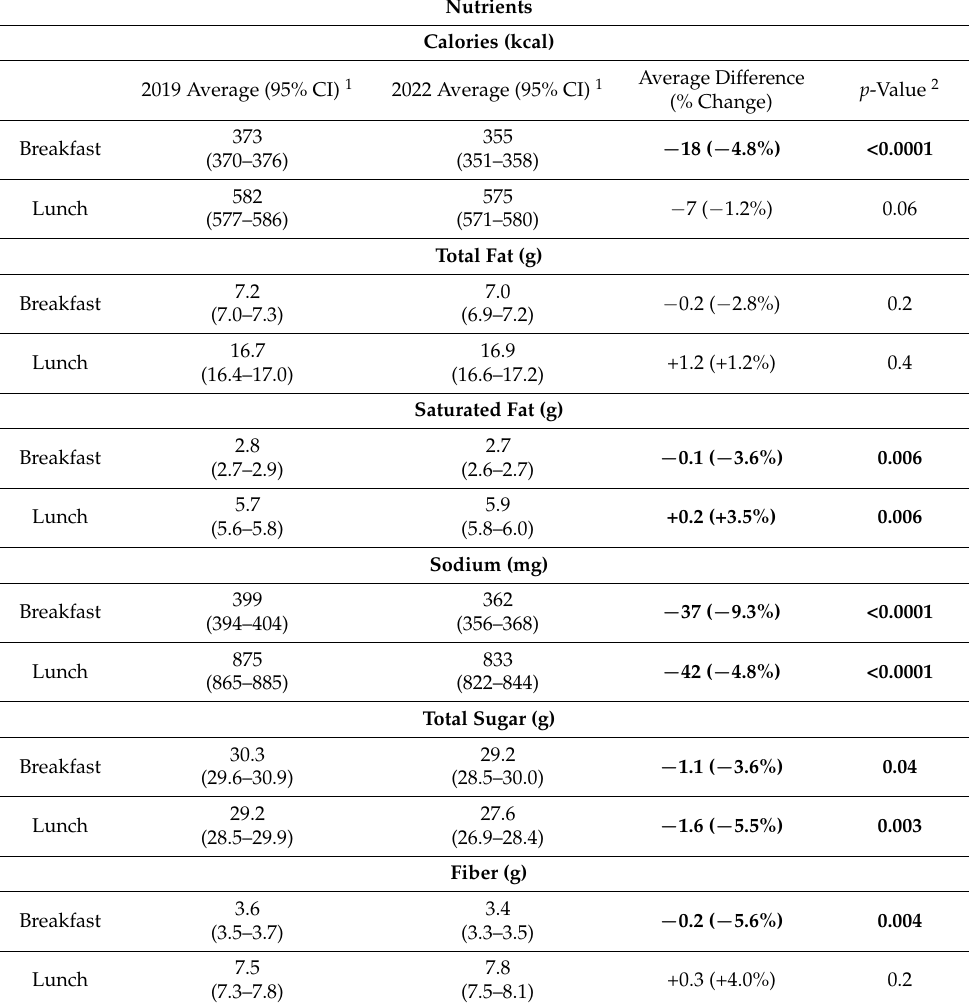
Table 1. Average nutrient contents of school districts’ breakfasts and lunches in a nationally represen- tative sample of elementary (K-5), comparing fall 2019 to spring 2022 ( n = 91 school